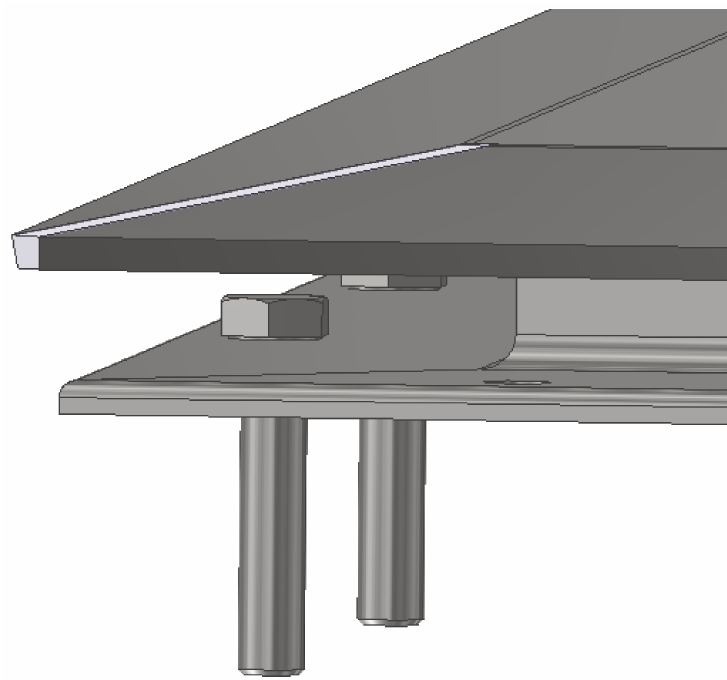
Figure 8. Fixing the hatch frame.